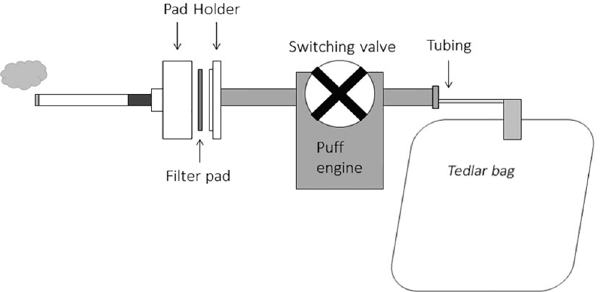
Fig 1. Pad + Bag mainstream smoke collection